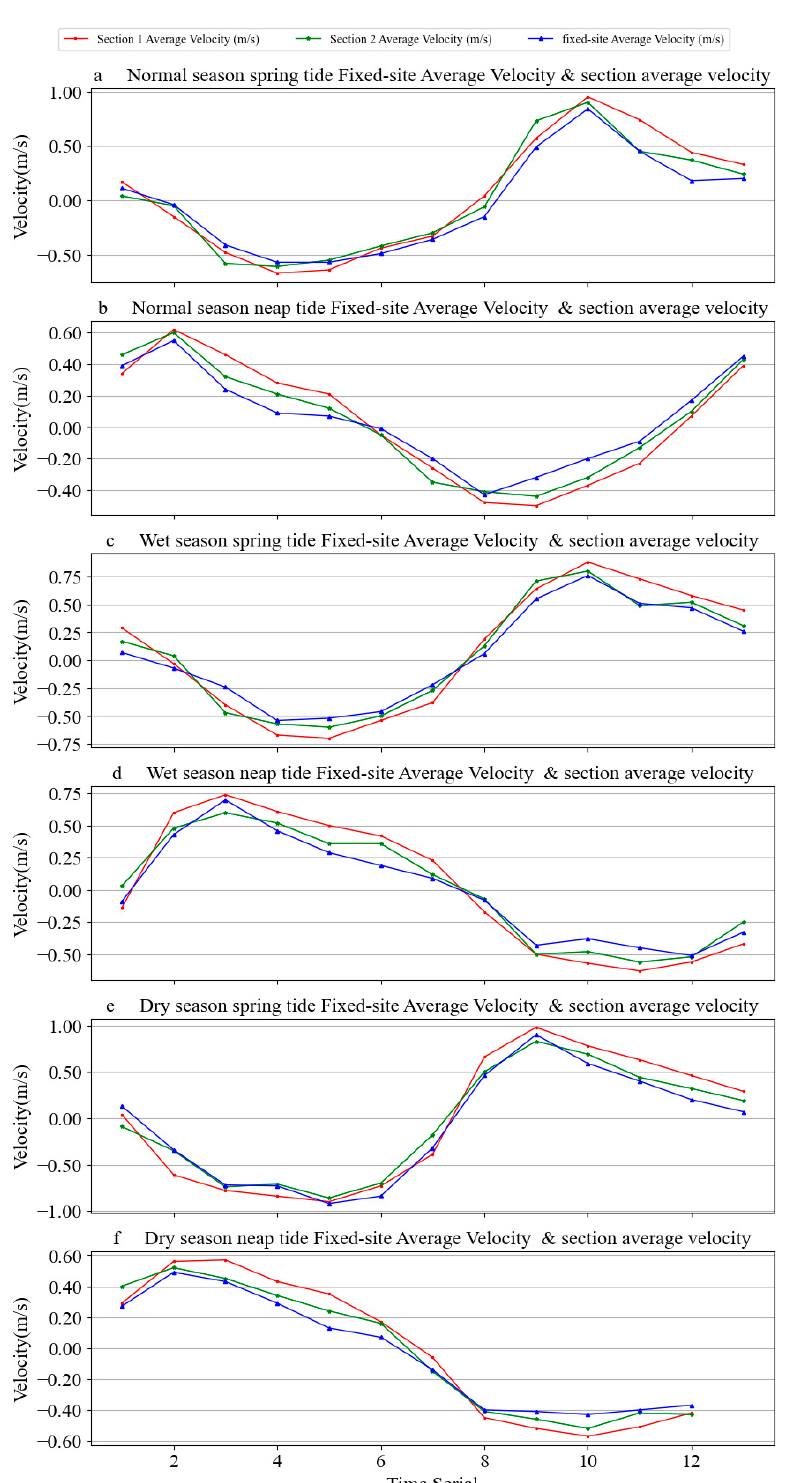
Figure 6. Process curve of fixed-site buoy vertical average velocity and section average velocity. ( a ) Normal season spring tide average velocity & section average velocity of the fixed-site, ( b ) Normal season neap tide average velocity & section average velocity of the fixed-site, ( c ) Wet season spring tide average velocity & section average velocity of the fixed-site, ( d ) Wet season neap tide average velocity & section average velocity of the fixed-site, ( e ) Dry season spring tide average velocity & section average velocity of the fixed-site, ( f ) Dry season neap tide average velocity & section average velocity of the